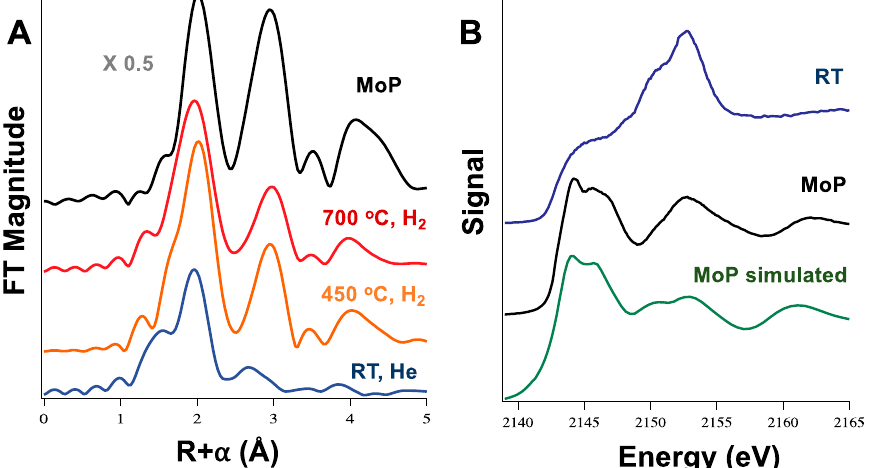
Figure 3. ( A ) Fourier Transform of the Extended X-ray Absorption Fine Structure (EXAFS) oscillation for the Mo K-edge collected in situ. Bottom to top: as-synthesized colloidal MoP nanoparticles at room temperature (RT) in He; MoP nanoparticles at 450 ◦ C in H 2 ; MoP NPs at 700 ◦ C in H 2 . ( B ) XANES spectra at P K-edge (air-exposed samples). Bottom to top: Simulated XANES at P k-edge for crystalline MoP; crystalline MoP; as-synthesized MoP colloidal NPs.